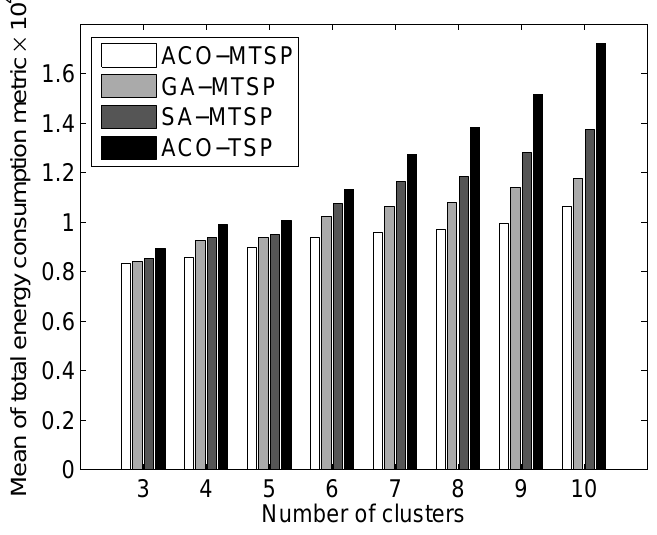
Figure 8. The mean of total energy consumption metric optimized by ACO-TSP, SA-MTSP, GA- MTSP and ACO-MTSP with different number of clusters, where the number of clusters changes from 3 to 10 and the number of sensor nodes keeps 200 for all experiments.